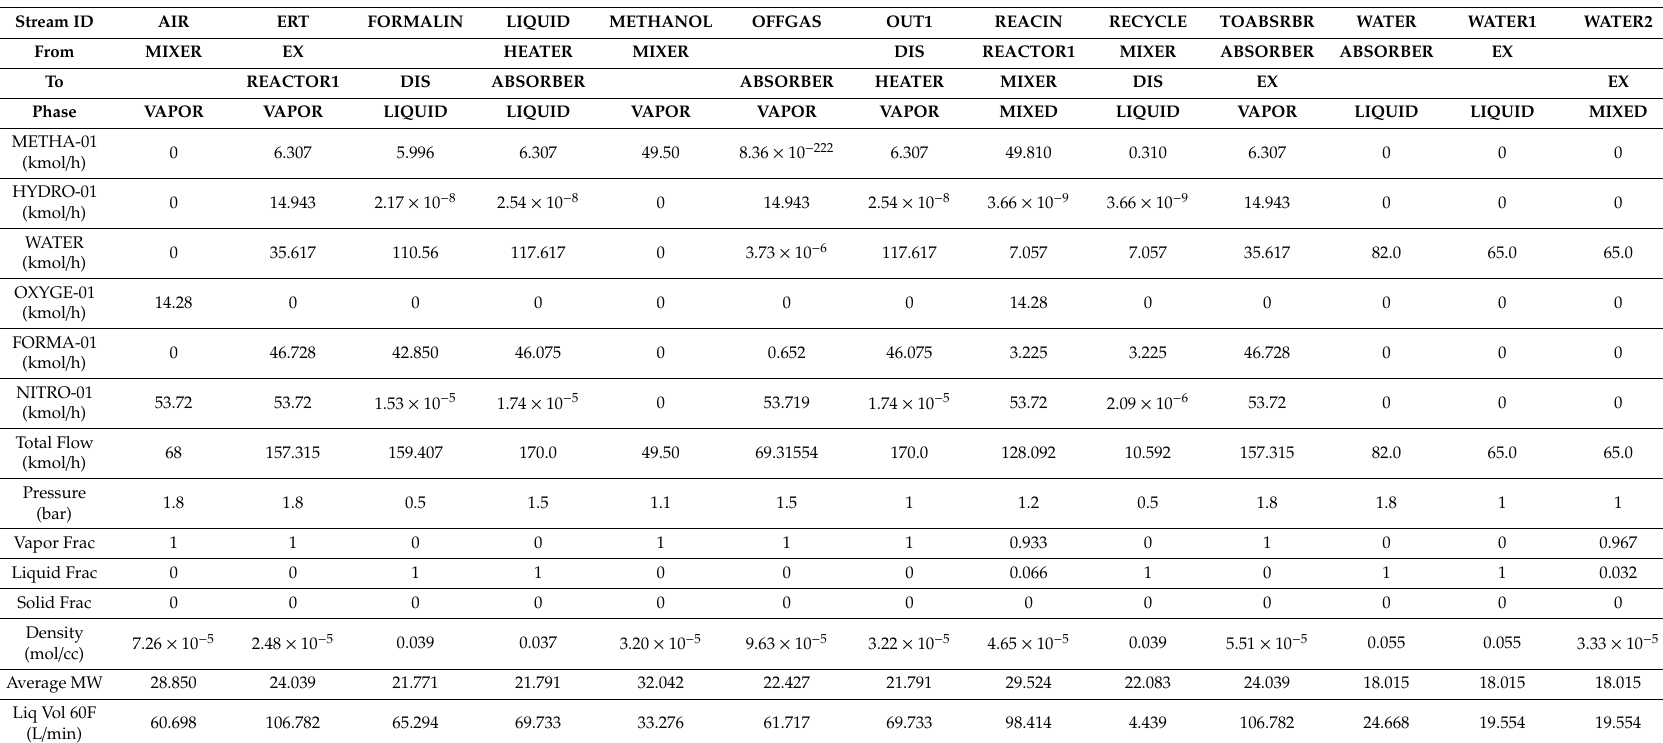
Table 4. Material balance of silver-based